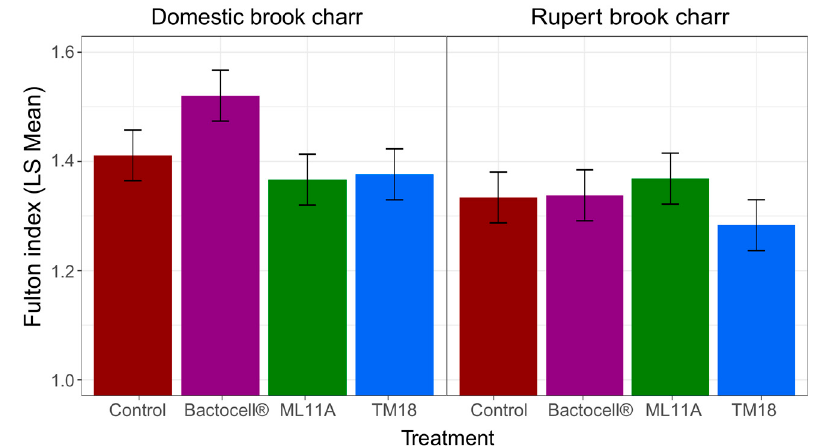
Figure 5. Average Fulton condition factor of Domestic and Rupert brook charr after 120 days of daily treatment exposure ( n = 18 fish per treatment). Bars are least-square (LS) mean estimates, and horizontal lines represent the 95% confidence interval for each mean estimate. Control: no probiotic treatment. Table 4. Two-factor ANOVA of the Fulton condition factor, with Treatment and Lineage as explanatory variables.